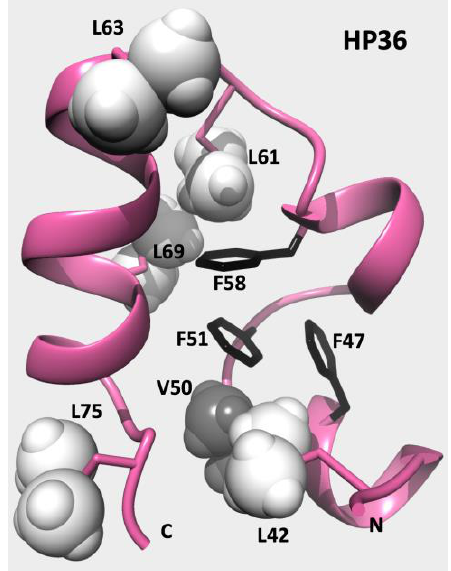
Figure 1. Ribbon diagram of HP36 protein (PDB ID: 1VII) with leucine and valine methyl groups in the otherwise perdeuterated protein are shown in a space-filling representation. The helices and the three core phenylalanine residues (black sticks), as well as N- and C-termini are labeled.